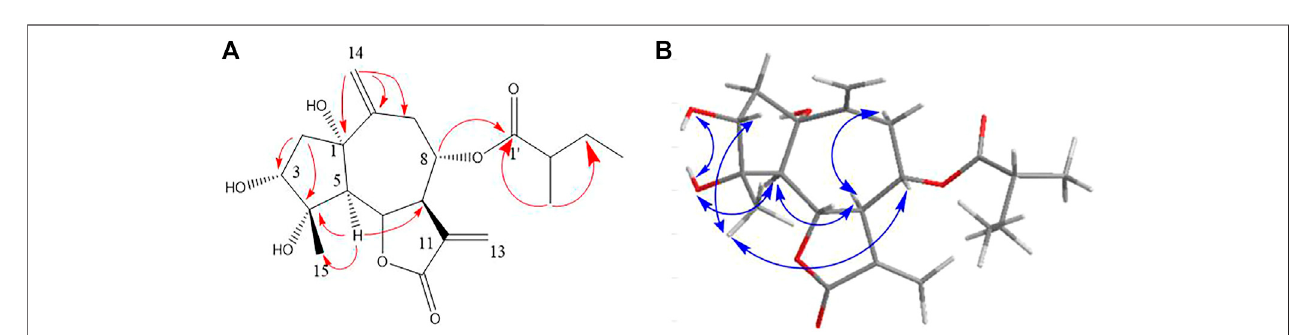
FIGURE 5 | Key HMBC (A) and NOESY (B) correlations of compound 2 .